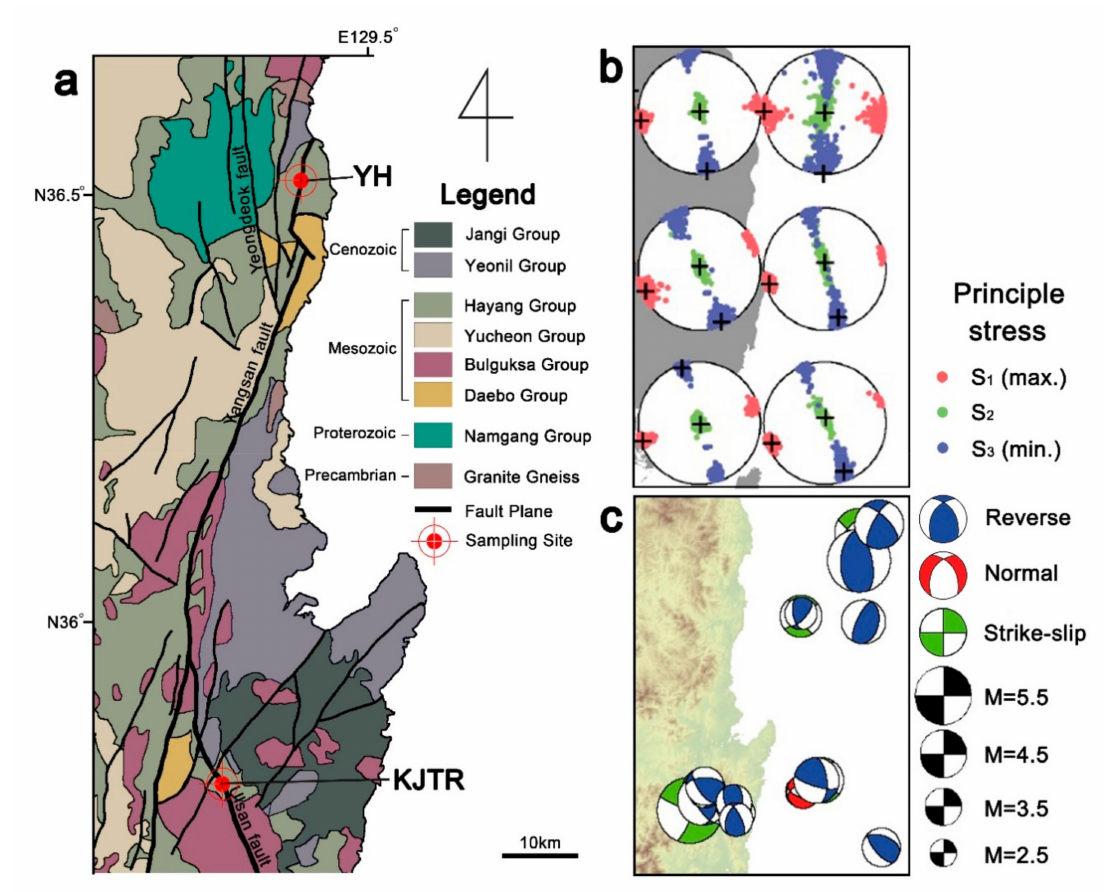
Figure 1. ( a ) Geological map of the southeastern part of Korea Peninsular (modified from the Korean Institute of Geoscience and Mineral Resources (KIGAM) geological map 1:1,000,000 [30]). Samples were obtained from the NNE-SSW striking Yangsan fault zone and NNW-SSE striking Ulsan fault zone; ( b ) Results of stress inversions using the misfit angle method (modified from Soh et al., 2018 [29]); ( c ) Map of the Southeastern Korean Peninsula showing the recent earthquake focal mechanisms (modified from Soh et al., 2018